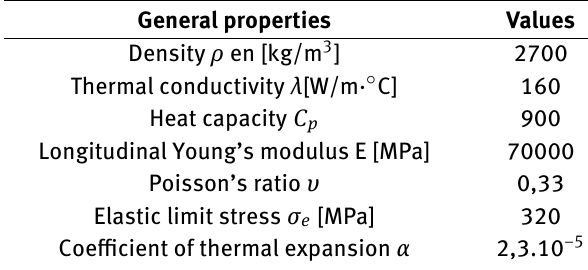
Table 1: Mechanical properties of aluminum